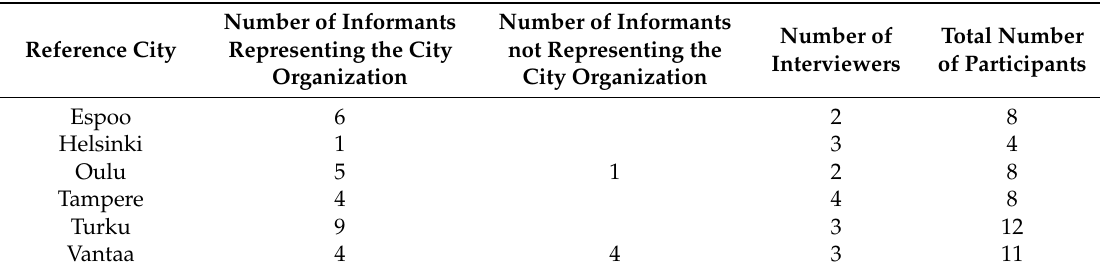
Table 2. Participants in the